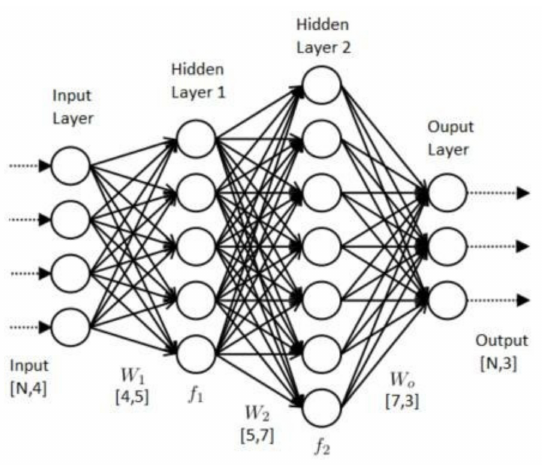
Figure 11. Artificial neural